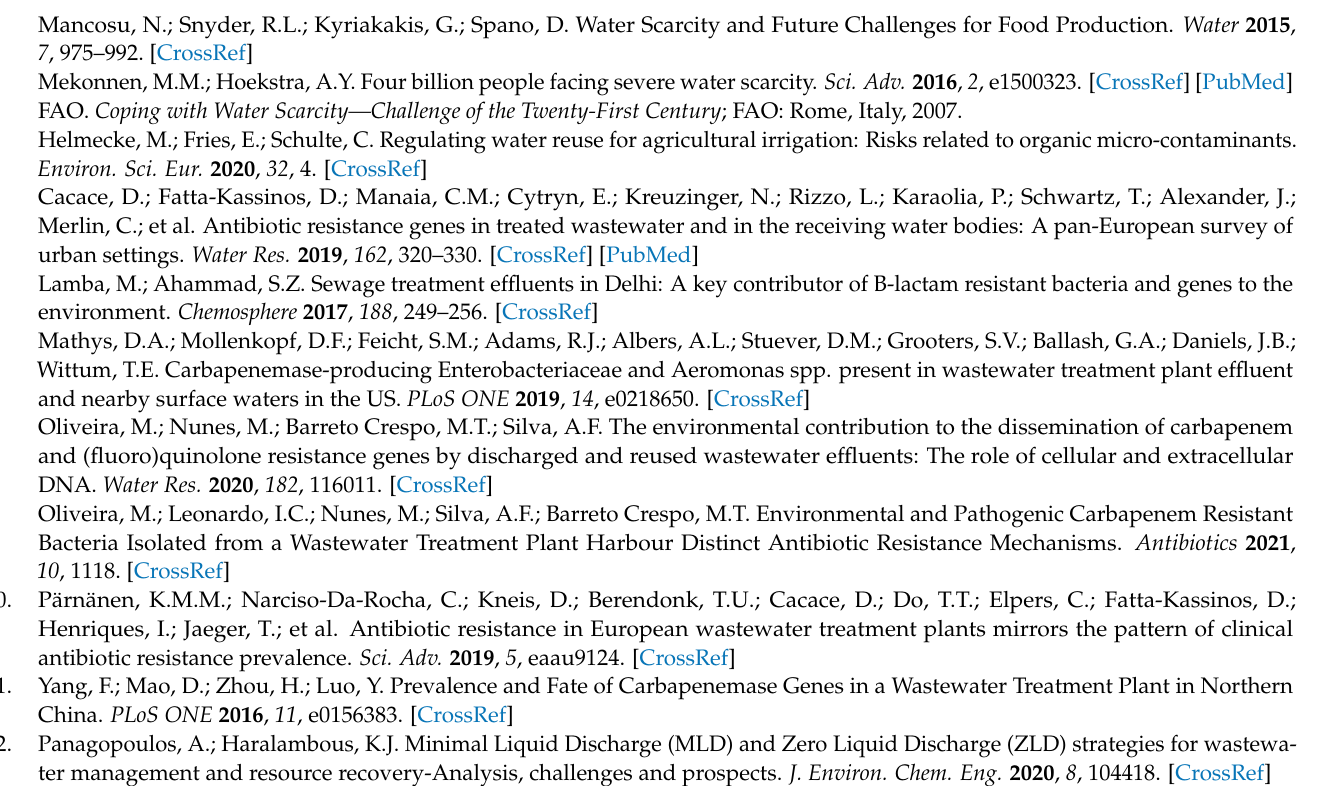
fraction; Table S5: Concentrations of the target carbapenem and (fluoro)quinolone resistance genes present in the eDNA fraction of the discharged effluent, reused effluent, nanofiltered water and tap water samples. Values are expressed in gene copy numbers per milliliter and correspond to the mean ± standard deviation of biological and technical triplicates; Table S6: Removal rates of the the reused effluent and nanofiltered water samples in the eDNA fraction; Table S7: General analytical control parameters of the discharged effluent samples collected for this